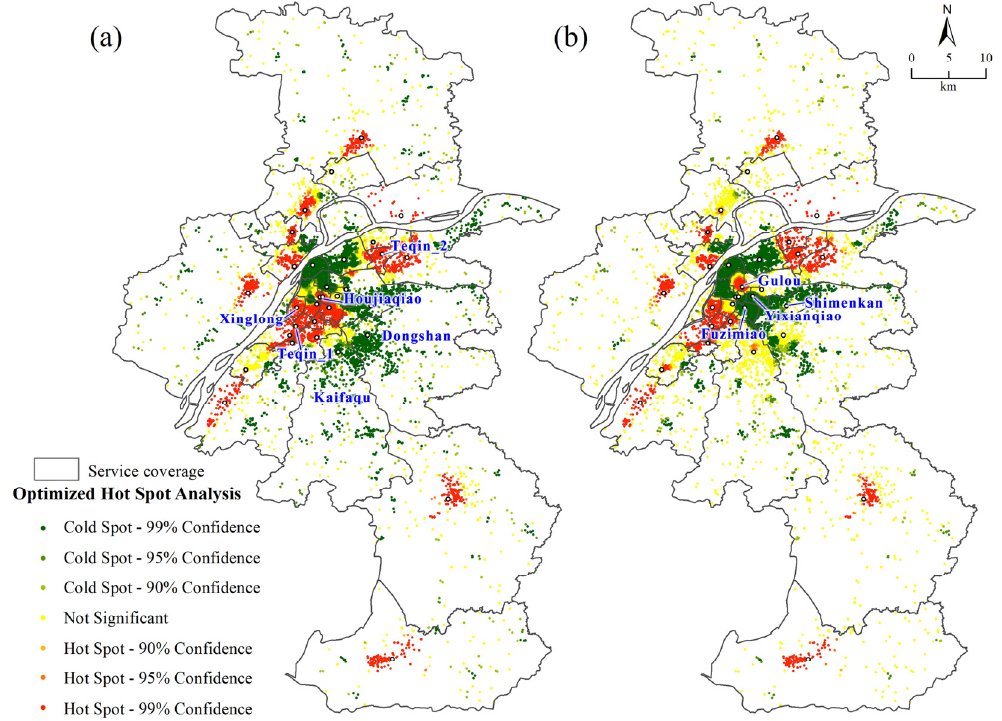
Figure 7. Optimized Hot Spot Analysis of spatial accessibility of fire incidents using ( a ) E2SFCA, ( b ) ( b ) FC2SFCA.